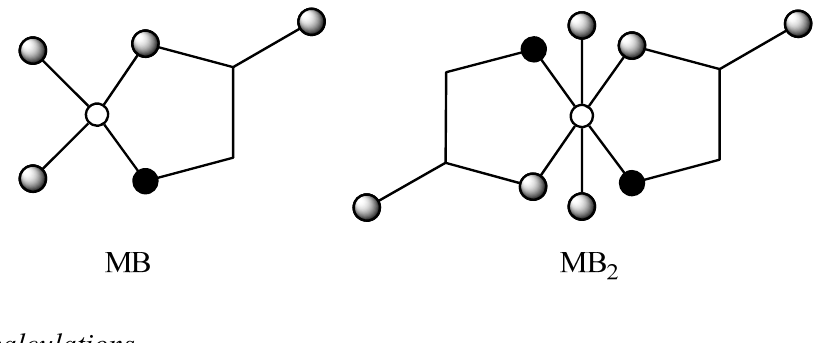
Figure 1. The graph representations for metal(II) mono - (MB) and bis -complex (MB glycine. Heteroatoms are marked